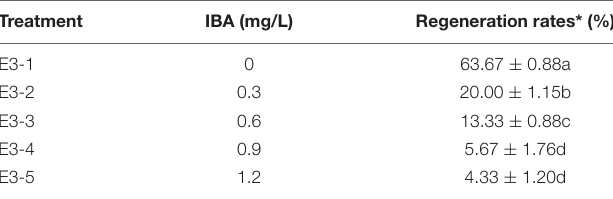
TABLE 5 | Germination of somatic embryos with different concentrations of IBA in medium.